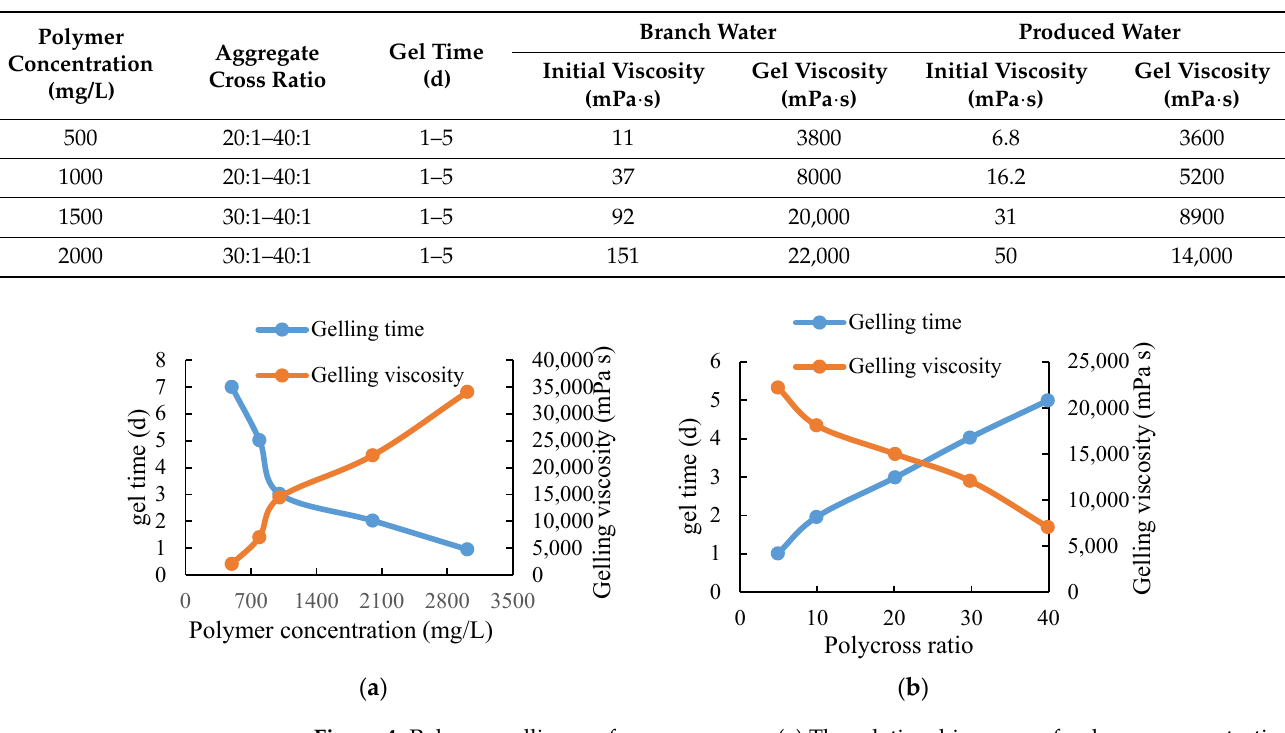
Table 2. Effects of concentration and polymer-to-cross ratio on gel formation.